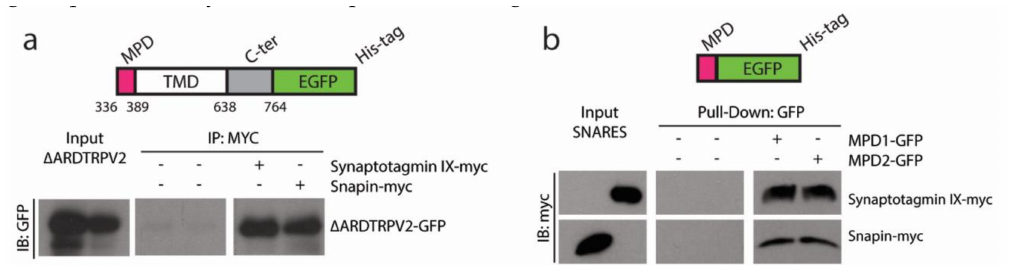
Figure 1. Mapping of the TRPV interaction with SNARE proteins. ( a ) Co-IP of human embryonic kidney 293 (HEK293) cells transfected with TRPV2 lacking N-terminal ARD domain GFP-tagged ( ∆ ARD-TRPV2-GFP) and Snapin-25 or Synaptotagmin-IX c-myc-tagged. The lysates were immunoprecipitated with anti-c-myc. ( b ) In vitro pull-down assay using purified MPD region from TRPV1 or TRPV2 channels GFP-tagged to pull-down c-myc-tagged Snapin or Synaptotagmin-IX in lysates from HEK293 transiently transfected cells. MPDs-GFP were immobilized on GFP-Trap beads. IP: immunoprecipitation; IB: immunoblotting. Co-IP experiments have been carried out in the absence ( − ) and presence (+) of c-myc antibody to assess the specificity of the interaction.